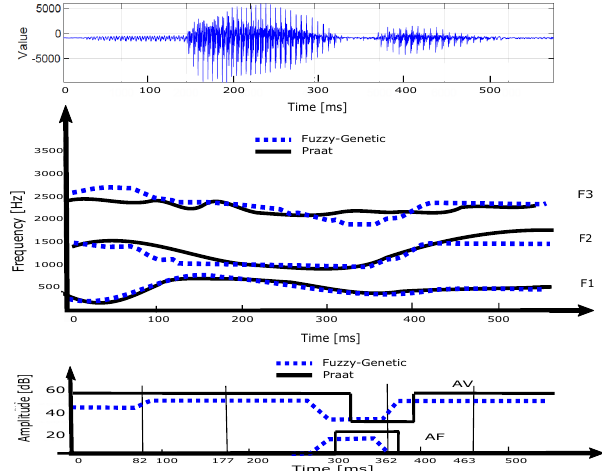
Figure 18. Acoustic analysis of the Italian word “nove”.